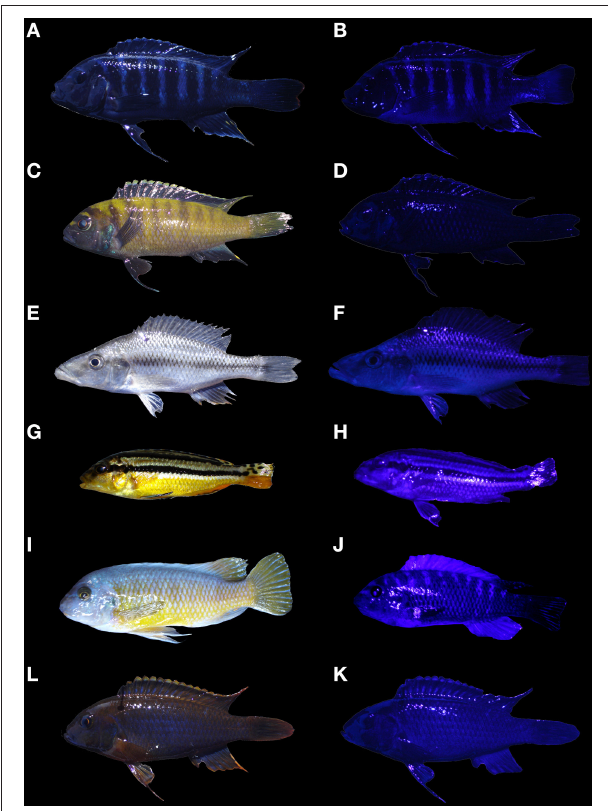
FIGURE 12 | Lake Malawi cichlid color patterns under full-spectrum light and UV lighting. (A,B), Metriaclima zebra ; (C,D) , Pseudotropheus flavus ; (E,F) , Dimidiochromi scompressiceps ; (G,H) , Melanochromis auratus ; (I,J) , Labeotropheus c.f fuelleborni “Katale;” (K,L) , Iodotropheus sprengerae . Species displaying different hues were selected to emphasize that the fundamental pattern, and the messages encoded therein, are independent of hue. In the barred and solid species, notice how UV lighting emphasizes the contrast between bars and background ( B , e.g.,) or among color pattern elements ( J , e.g.,), sometimes revealing hidden or de-emphasized contrasts (the highly reflective bars and the contrast between peduncle and flank in J ). In the striped species (E–H) , the balance among elements stays the same whether the illumination is full-spectrum or UV, thus suggesting that this pattern is meant to be visible and understood by all visual